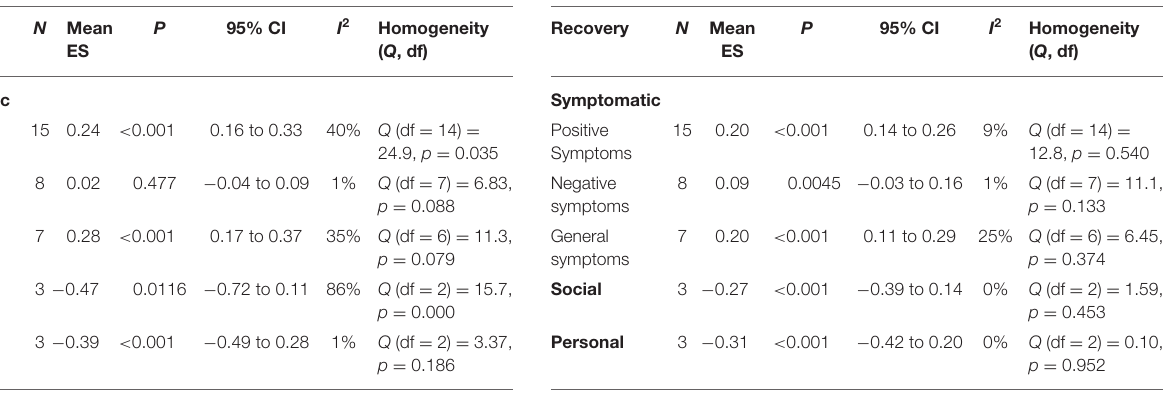
TABLE 3 | Anxious attachment and recovery outcome. TABLE 4 | Avoidant attachment and recovery